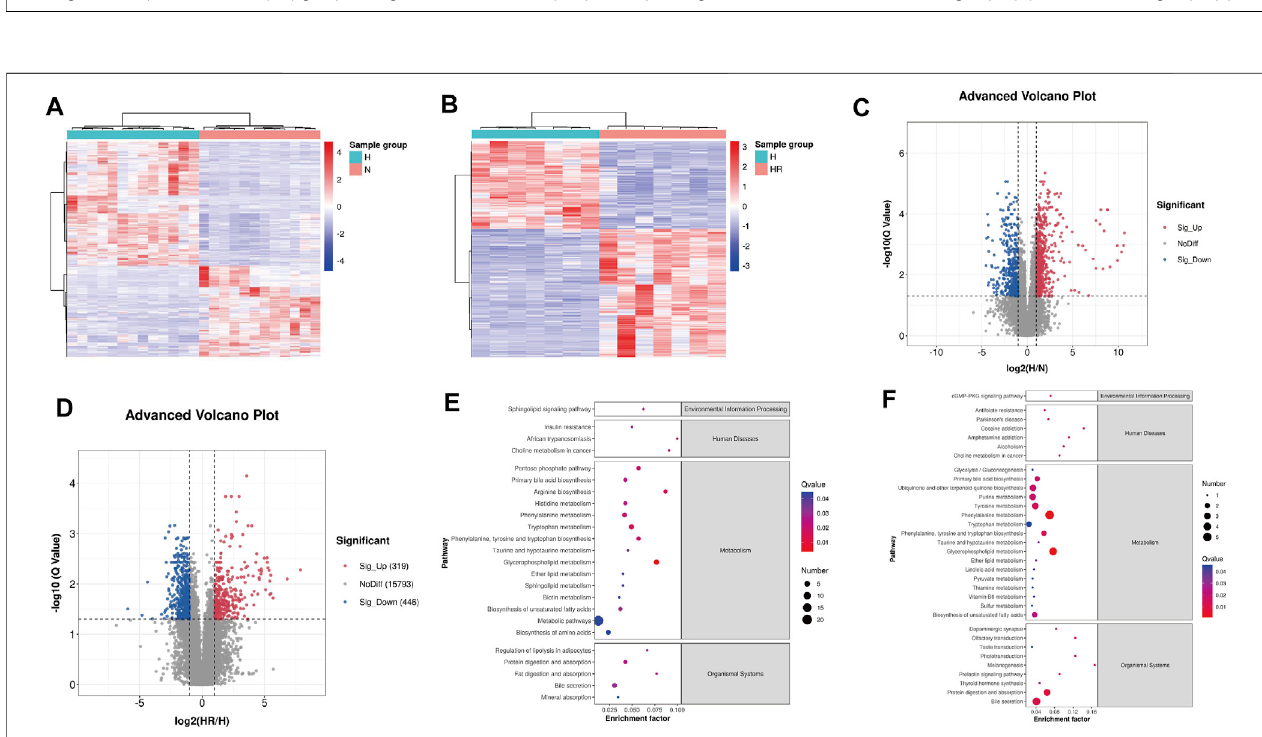
FIGURE 4 | Metabolic pro fi ling analysis of liver samples. (A) Three-dimensional score plot of the samples using the PCA model. (B) Two-dimensional score plot of the samples using PCA model. (C) Relative standard deviation (RSD) distributions of ions in QC samples. (D,F) Score plot of samples from normal (N), high-fat diet (H), and high-fat diet plus resveratrol (HR) groups using the PLS-DA model. (E,G) Corresponding validation of PLS-DA of N and H groups (D) , and H and HR groups (F) .